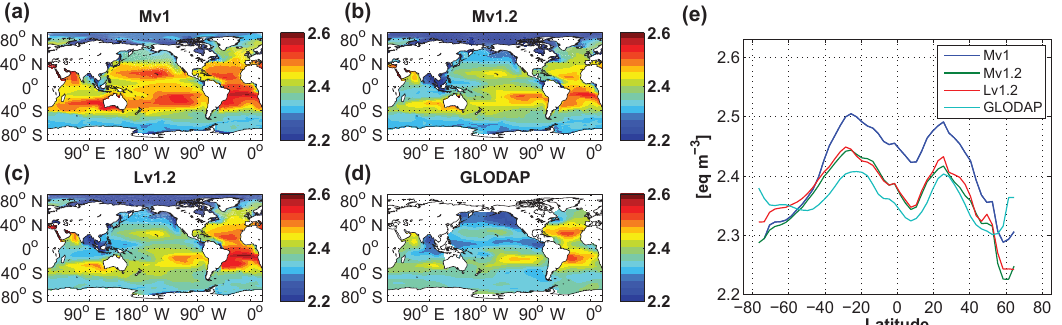
Figure 18. As Fig. 17 but for surface total alkalinity (eqm − 3 ).